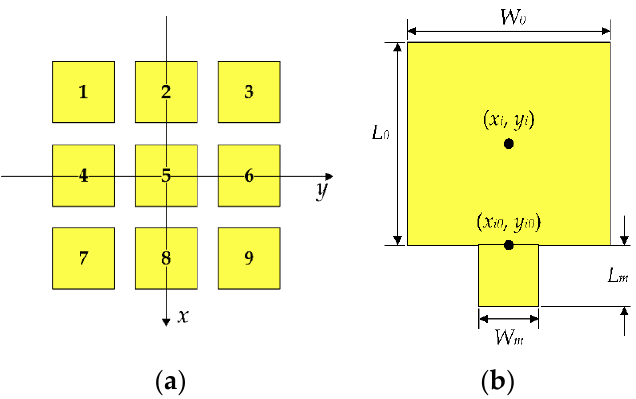
Figure 6. ( a ) Reconfigurable microstrip antenna coordinate system and patch number; ( b ) coordinate system of the i th patch element.